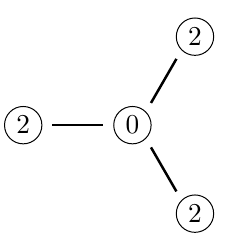
Figure 12. Decorated Dynkin diagram for the [5 ; 3] partition of